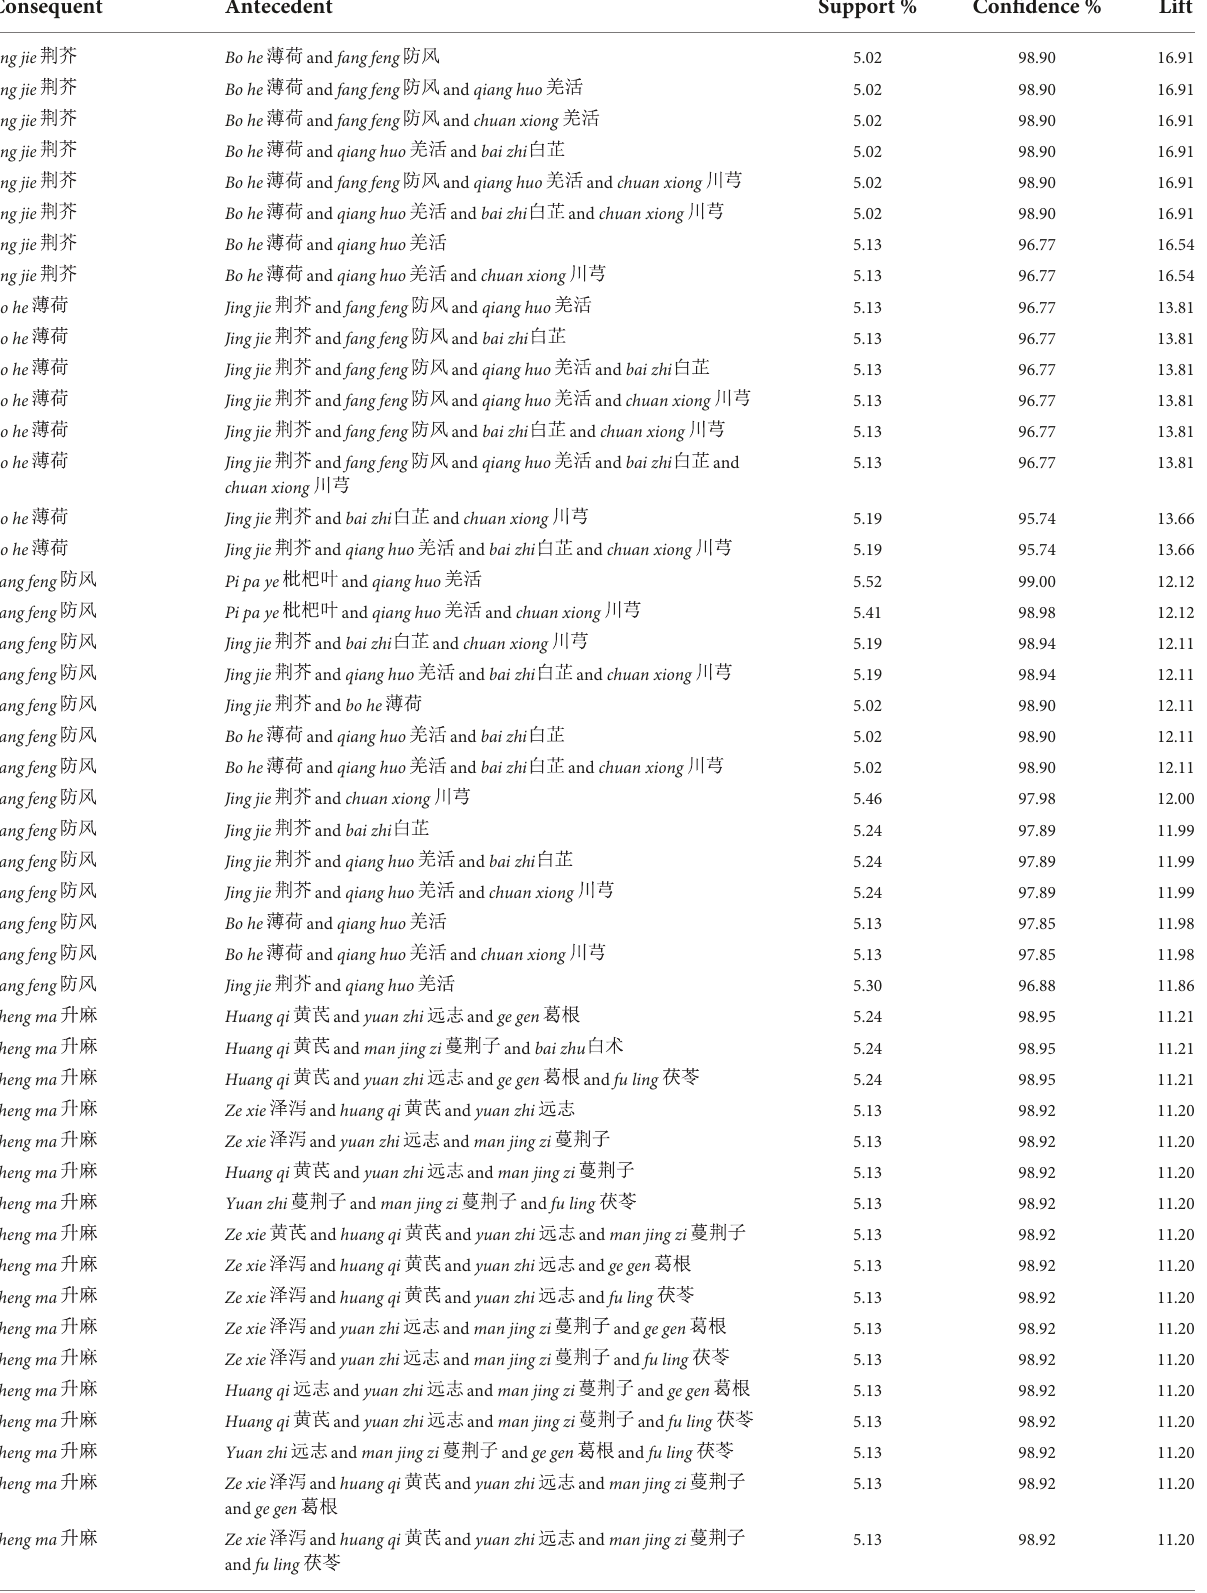
TABLE 6 Core herb combinations in Chinese herbal decoctions for which patients reported improvements. Consequent Antecedent Support % Confidence %